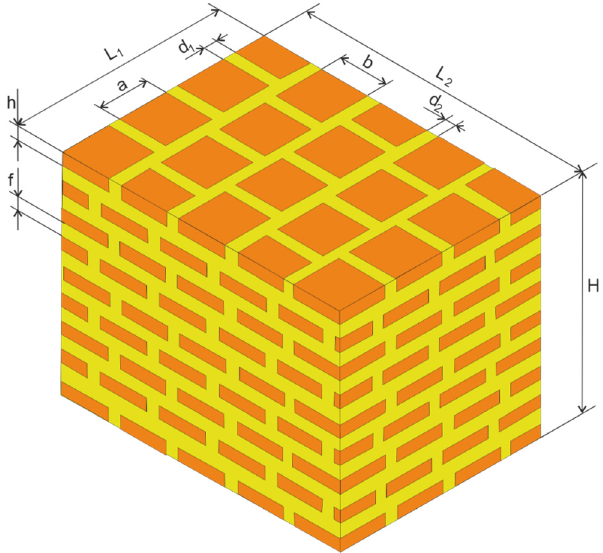
Figure 2. The three-dimensional model of the stratum corneum. Its size, L 1 · L 2 , corresponds to the area of the skin on which the process of migration of external substances into a living organism is considered.